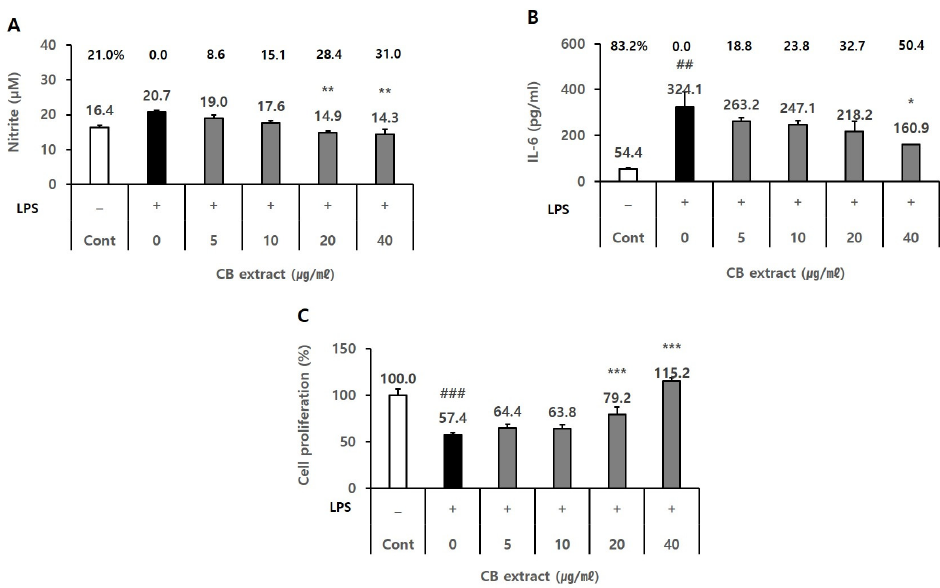
Figure 1. Effect of CB extract on ( A ) NO level, ( B ) IL-6 level, and ( C ) cell proliferation in LPS-treated BV2 cells. BV-2 cells (2 × 10 5 cells/mL) in 48-well plate were treated with sample extracts (at a final concentration of 5, 10, 20, 40 µ g/mL) for 2 h and with serum free media as control. The wells were reacted with 0.5 µ g/mL LPS for 24 h. The optical density of the reaction supernatant for the nitrite assay was measured at 520 nm. Supernatant (100 µ L) from each well was also used to measure the effect on IL-6 release using an ELISA kit at the wavelength of 450 nm. An MTT assay on the remnant cells that were treated with CB extract (5–40 µ g/mL) was conducted at 540 nm. ( − ), LPS-untreated experiment; (+), LPS-treated experiment. LPS, lipopolysaccharide. Cont, control. Significance was determined by one-way ANOVA with post hoc Tukey’s multiple comparison test. Data are presented as means ± standard errors of the mean (SEM). ## p < 0.01, ### p < 0.001 significance compared with the control (white bar). * p < 0.05, ** p < 0.01, *** p < 0.001 significance compared with LPS-treated cells (black